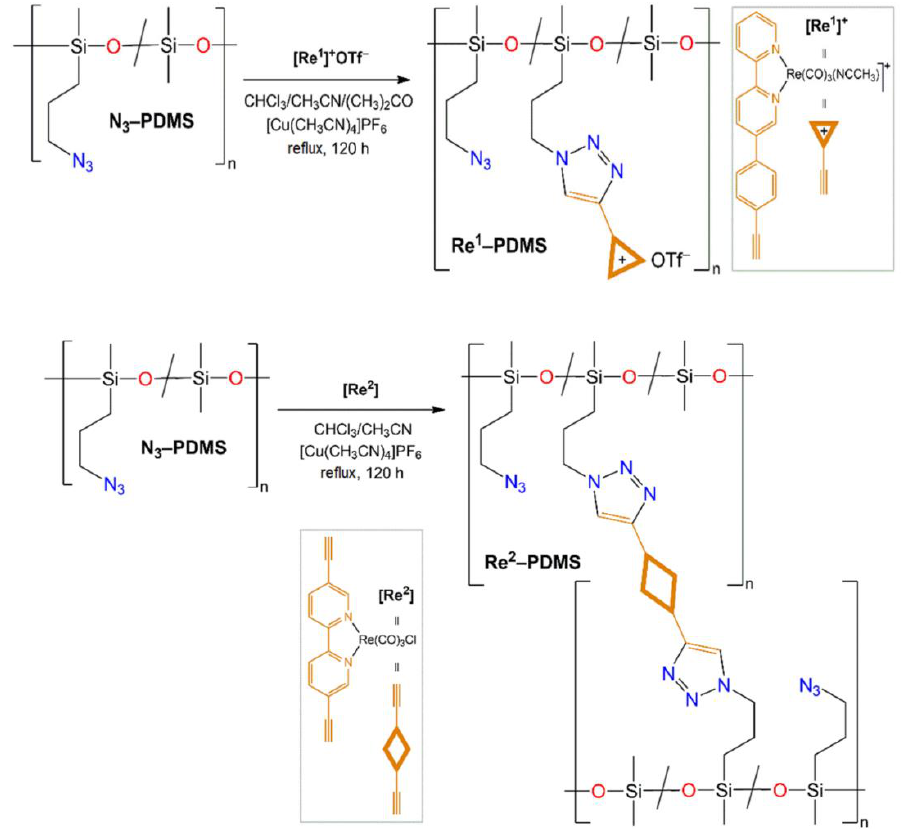
Figure 9. Scheme of Re 1 -PDMS and Re 2 -PDMS synthesis [99].